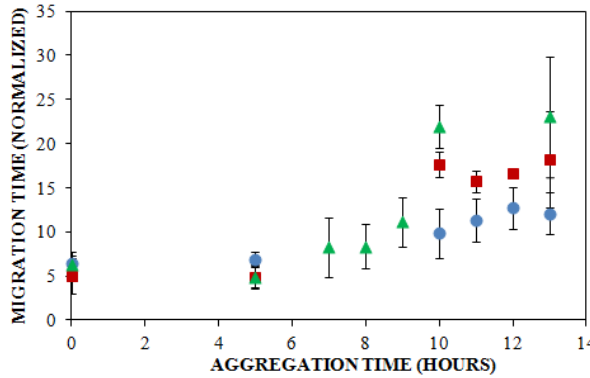
Figure 2. Effect of solution ionic strength on the formation of insulin oligomers detected by UV-CE. Insulin was diluted to 0.2 mg/mL in 40 mM Tris (pH 8.0) containing 100 mM (  ), 150 mM (  ), or 250 mM (  ) NaCl. Aggregation was induced at 25 ° C by continuous agitation (185 rpm) and monitored using UV-CE. CE was performed with sample injection at 0.5 psi for 8 s with 15 kV separation using 1% PHEA separation matrix in a PHEA coated capillary. Migration times were normalized to those observed prior to the onset of aggregation using the peak corresponding to monomer to facilitate comparison between individual runs. Error bars represent SE, n = 3. For the 10 h time point, the migration times of the 150 mM and 250 mM NaCl were both determined to be statistically different from the 100 mM NaCl migration time with a p <